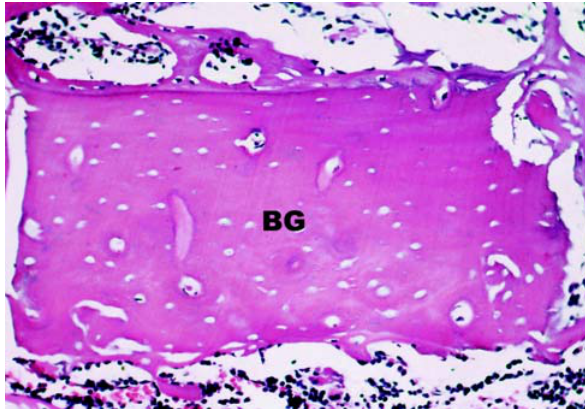
FIGURE 1- Group CG10: Bone fragments corresponding to the grafts (BG) and numerous osteoblasts (arrows) close to the newly formed bone tissue margins and the graft fragments. HE. (Original magnification x160)